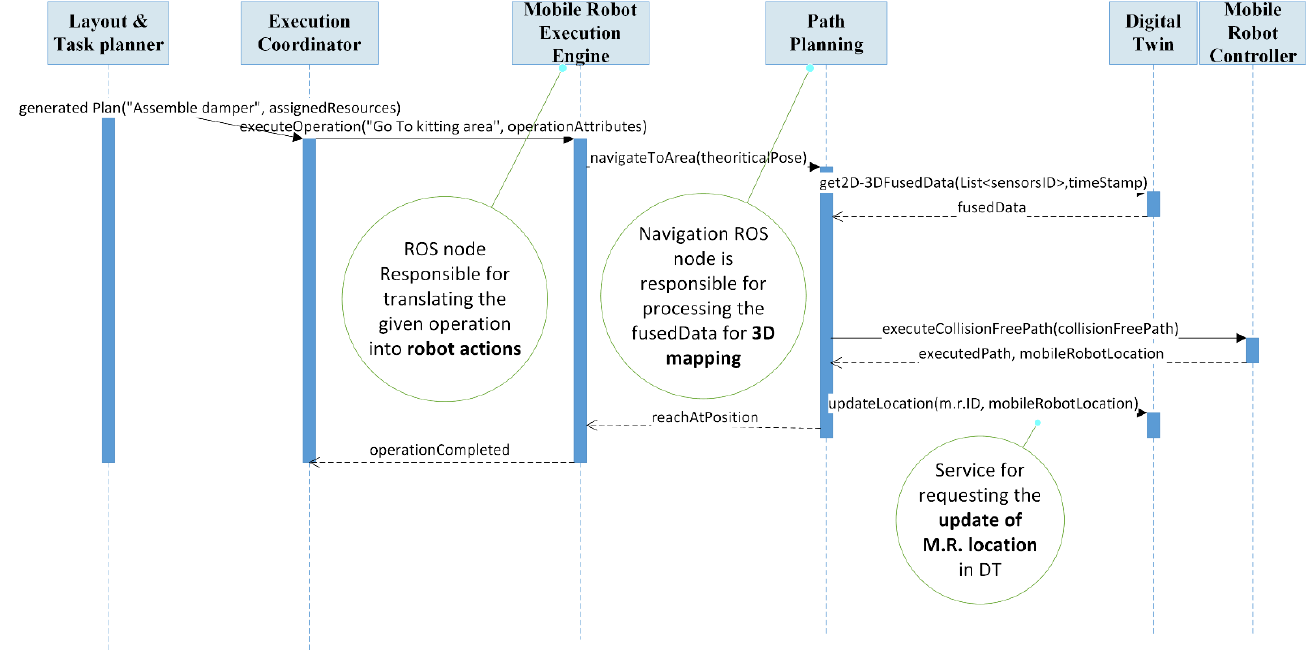
Figure 9. DT-based system sequence diagram for the execution of a Navigation Task.